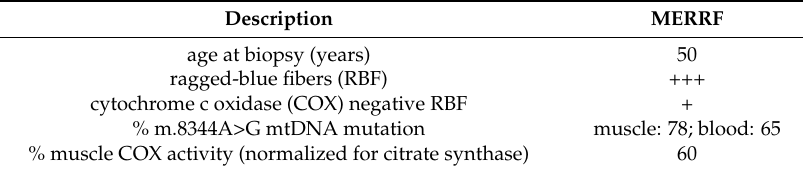
Table 1. Clinical, morphological, molecular and biochemical data on the selected myoclonic epilepsy with ragged-red fibers (MERRF) patient. Severity of myopathological features: absent ( − ) to severe